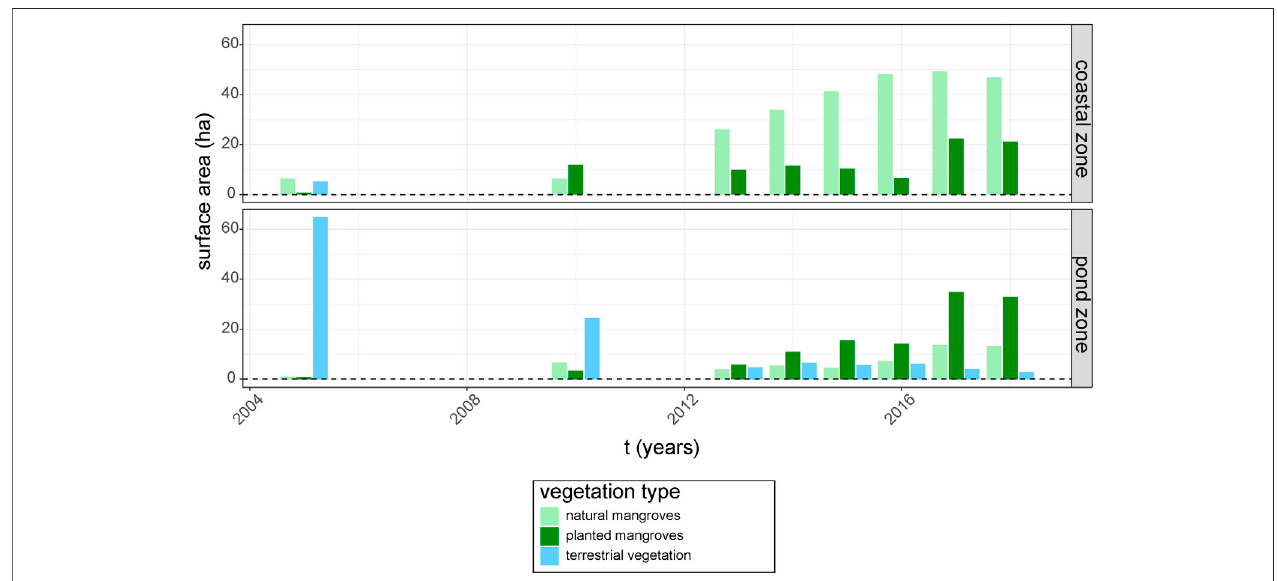
FIGURE 3 | Trends in total surface area (ha), digitized from high resolution images available in Google Earth, of the three vegetation types [terrestrial forestation, planted mangroves ( R. mucronata ) and naturally-recovered mangroves ( Avicennia spp.)] in the coastal zone and the pond zone from 2005 until 2018.